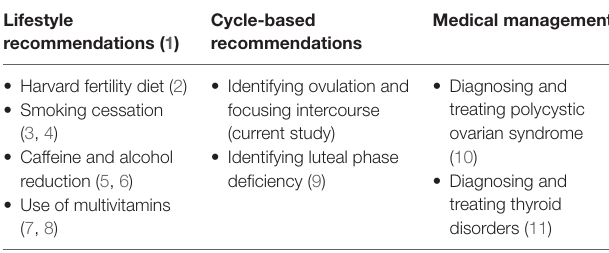
Table 1 | Some examples of primary care-based recommendations for optimizing natural fertility. lifestyle recommendations